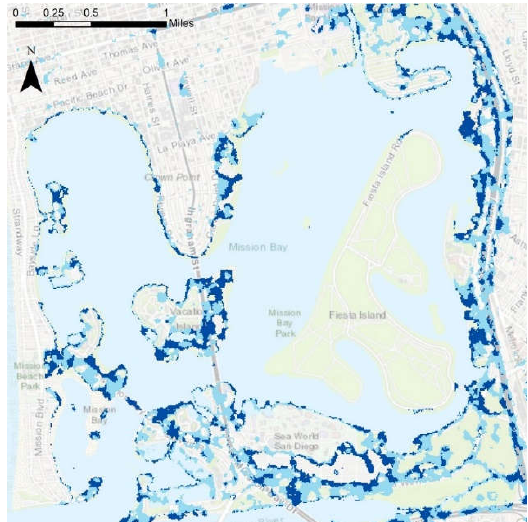
Figure 13. Mission Bay Submap.